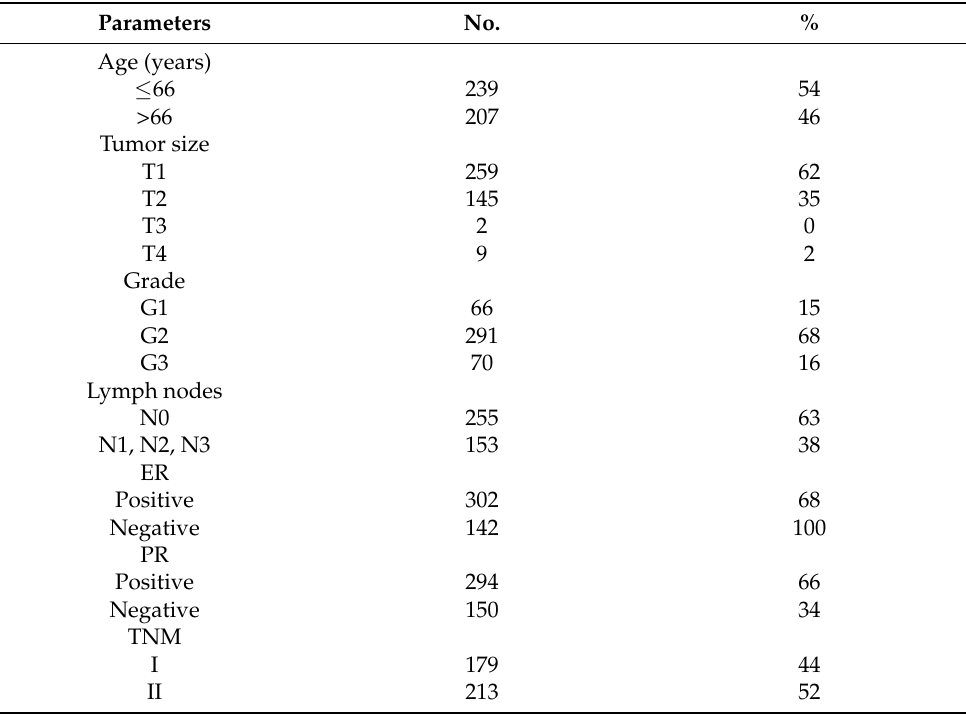
Table 2. Patient and tumor characteristics of invasive ductal breast cancer